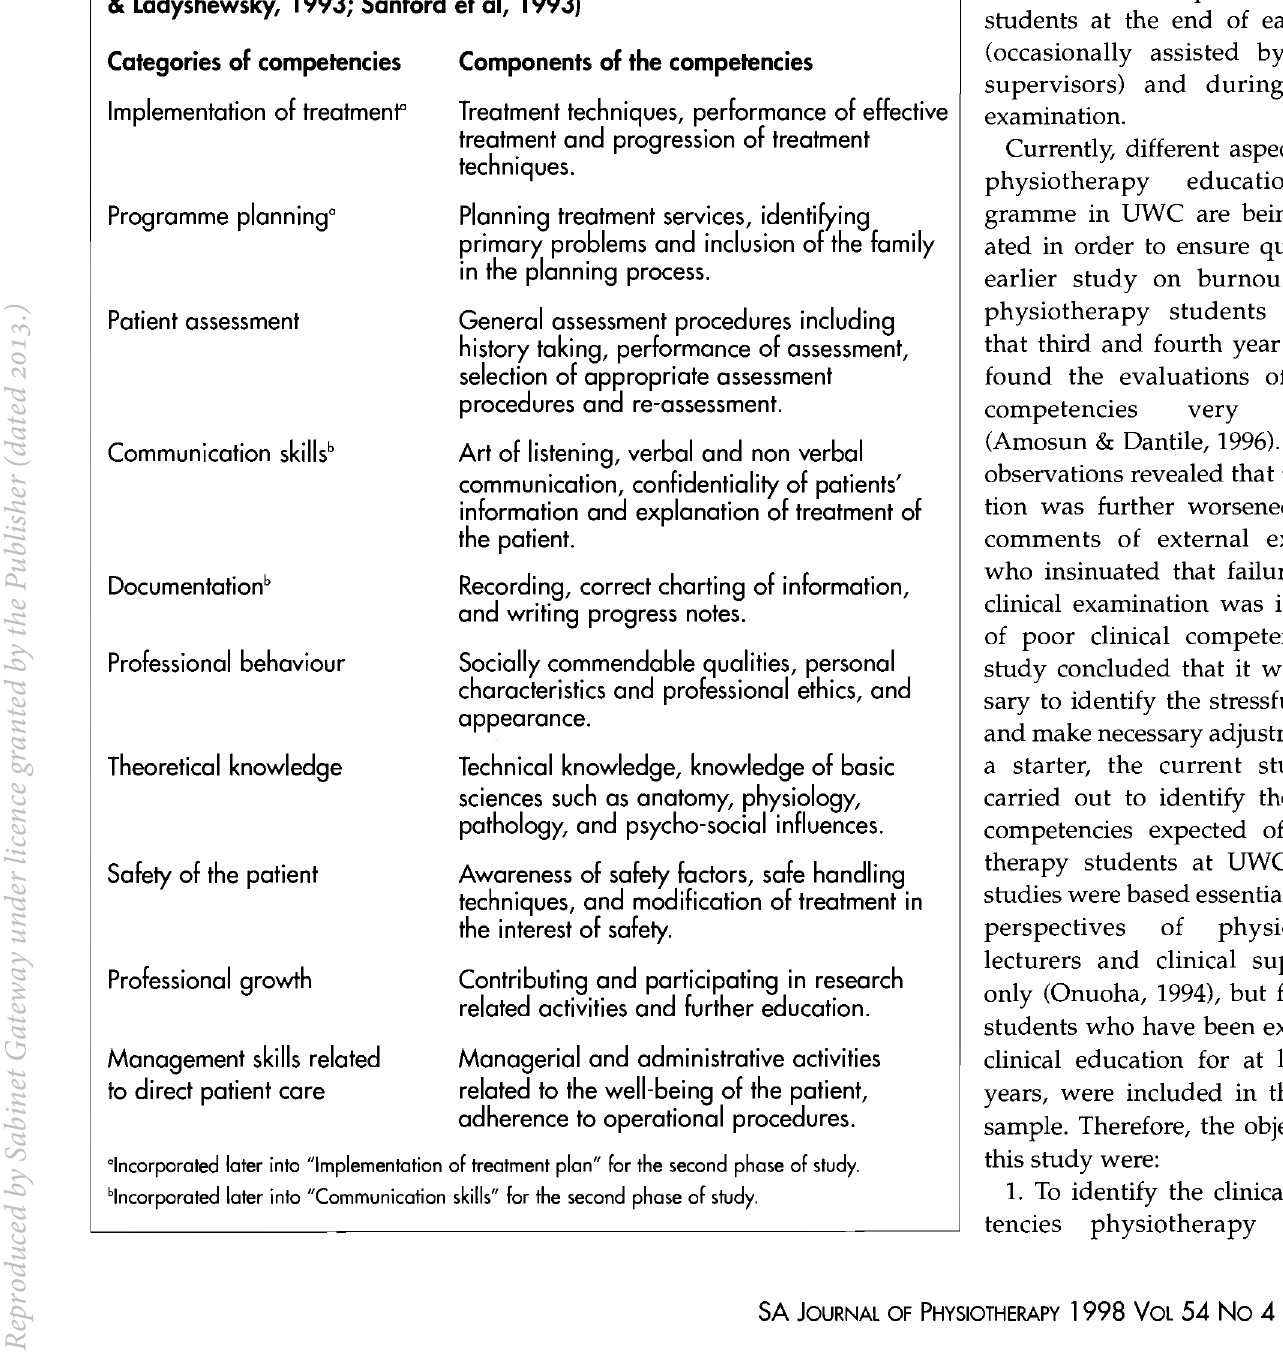
TABLE I: LIST OF EXPECTED CLINICAL COMPETENCIES (Loomis, 1985; Declute & Ladyshewsky, 1993; Sanford et al,